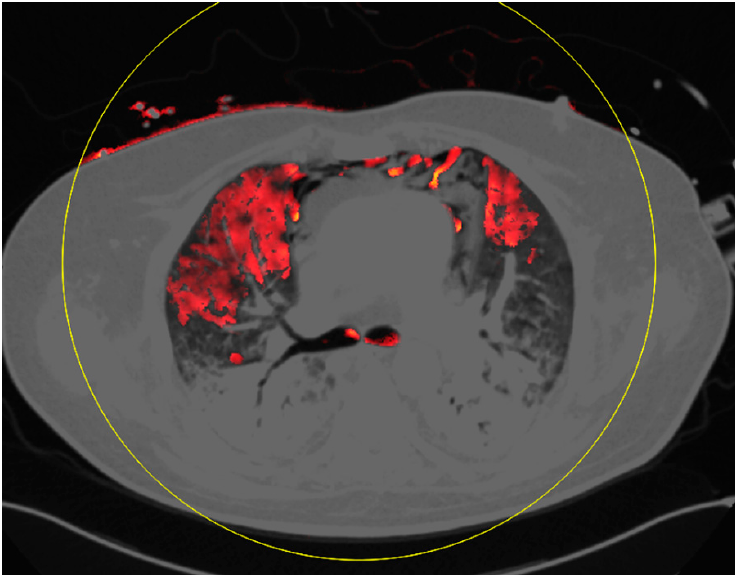
Figure 2. This example displays areas of ground glass opacities with perfusion defects (black arrow left lung) and ground glass opacities with normal perfusion (black arrow right lung).